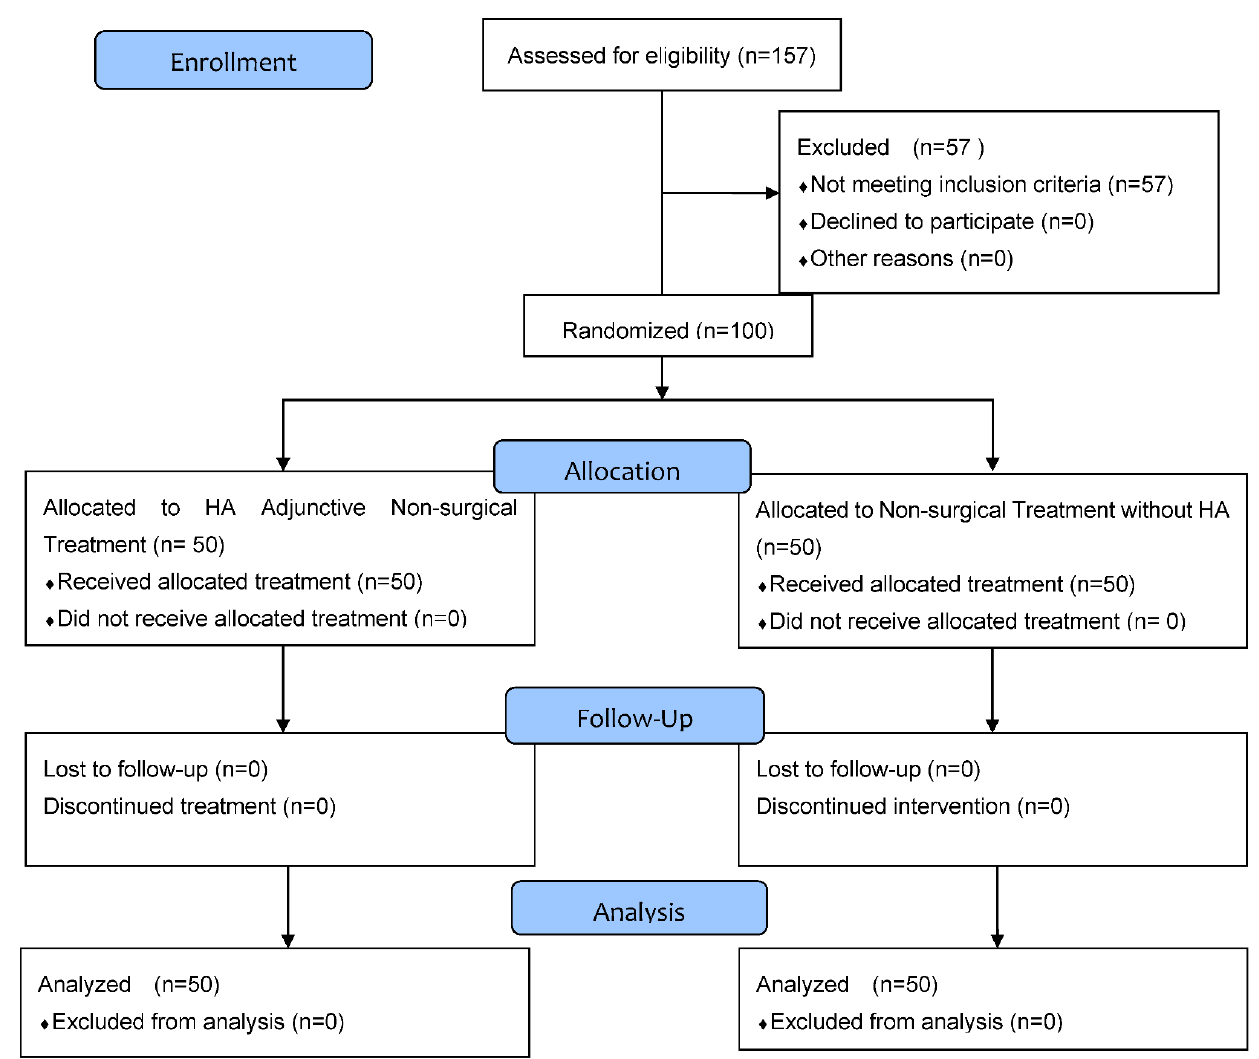
Figure 1. CONSORT 2010 flow diagram.